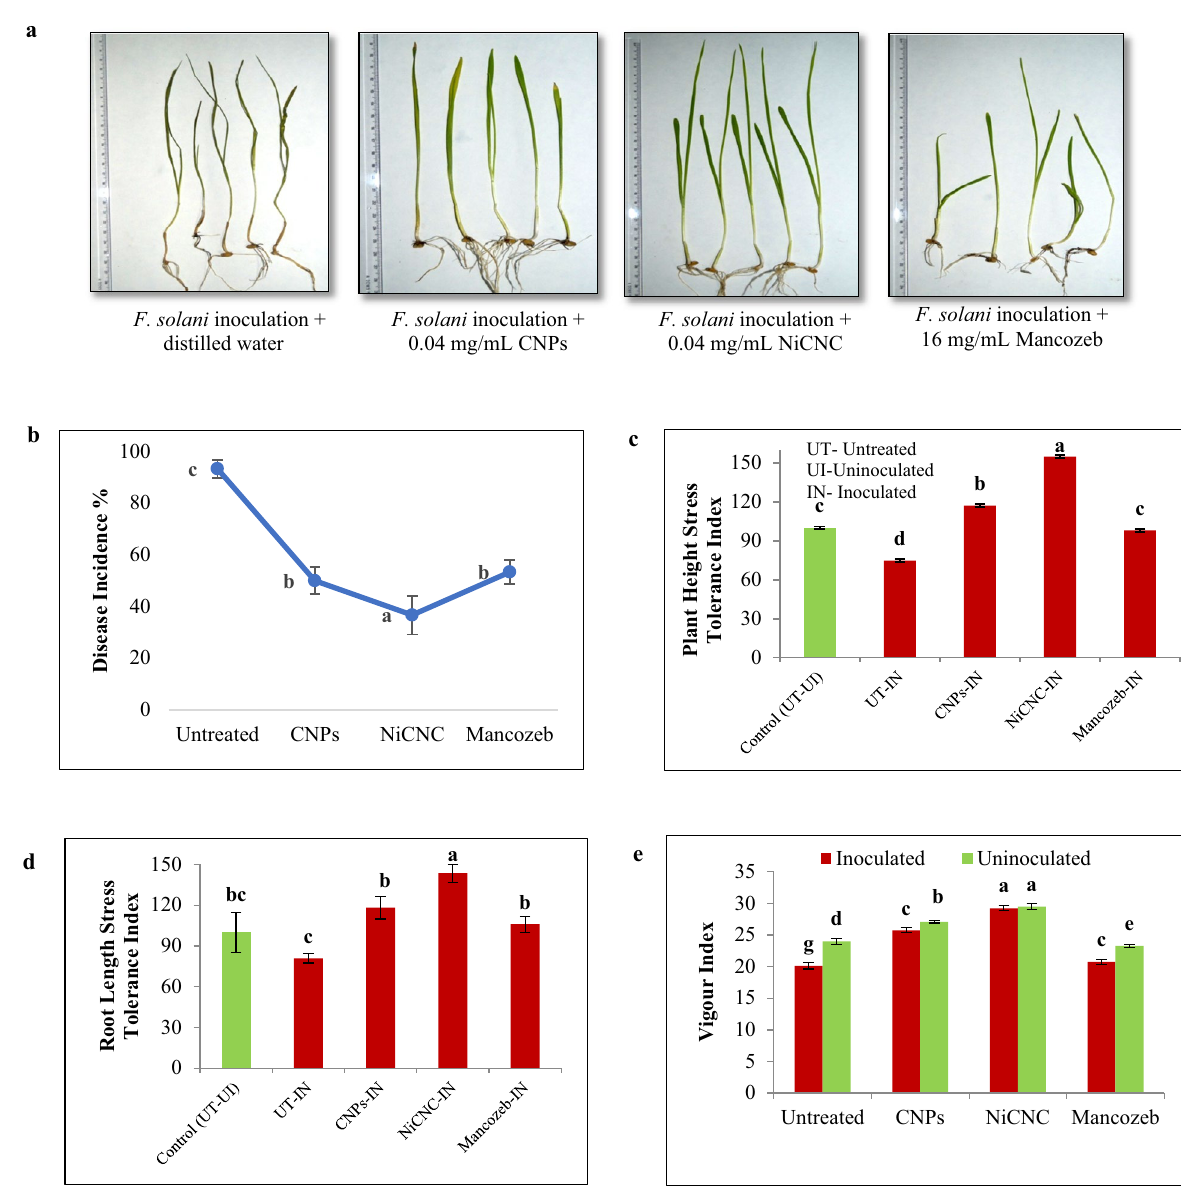
Figure 7. ( a ) Observation of morphological vigour of F. solani inoculated wheat seedlings at 20th day treated with distilled water, CNPs, NiCNC and Mancozeb; ( b ) disease incidence percentage of variably treated wheat seedlings; ( c ) Plant height and ( d ) Root length stress tolerance index of F. solani inoculated wheat seedlings treated with distilled water (untreated), CNPs, NiCNC and Mancozeb; ( e ) Vigour index of uninoculated and F. solani inoculated wheat seedlings at 20th day. Values are averages of three replicates (n = 3), error bars indicate SD and different letters (a, b, c, etc.) indicate significant difference between treatments at p ≤